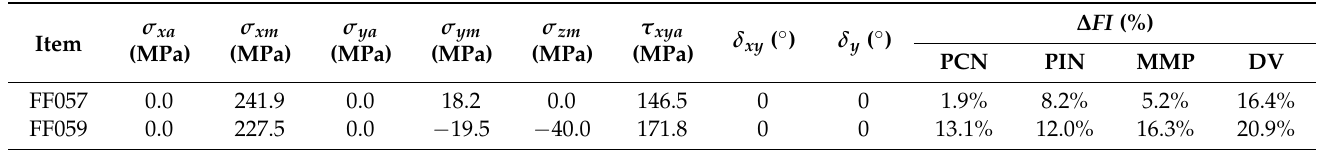
Table 8. Load cases including pressurizing in the AMSD25 data set and the response of reference multiaxial fatigue strength criteria to